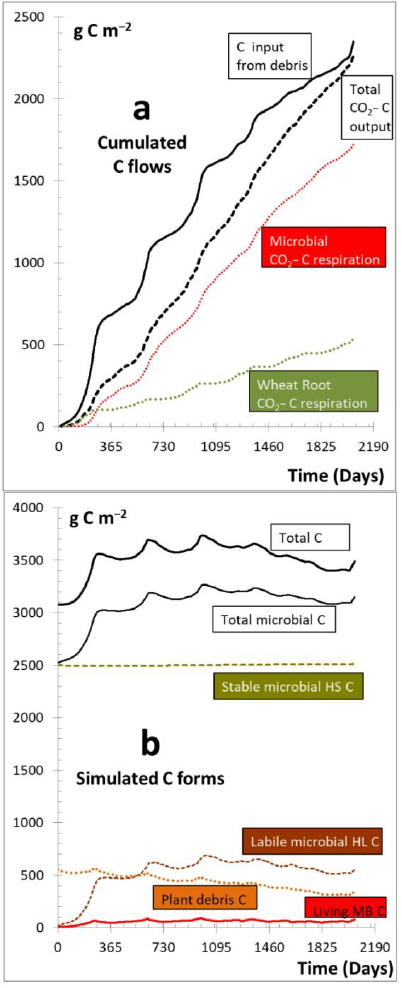
Figure 3. Prediction of the C evolution of the experimental Mediterranean soil after 6 years of unfertilized cereal/legume intercropping: ( a ) accumulated C inputs from photosynthesized debris (black continuous line) compared to accumulated outputs by respiration (black dashed line) of microorganisms (red) and plants (olive green), ( b ) simulated C during 6-year intercropping, total C and microbial C (plain black lines) originating from plant debris (orange dashed line), living microorganisms (red), labile humus (HL, Brown), and stable humus (HS, green